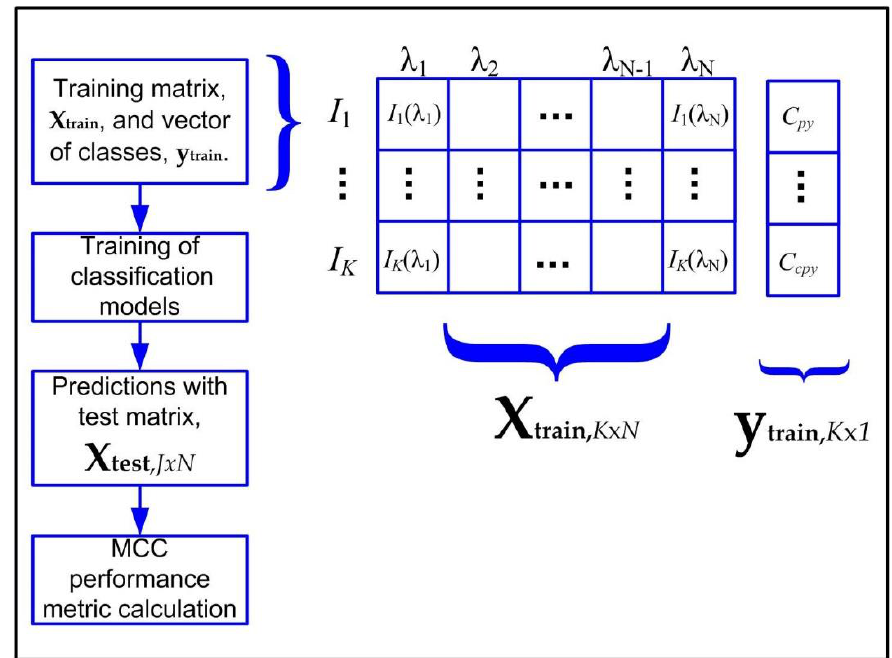
Figure 3. General classifiers training and prediction pipeline.